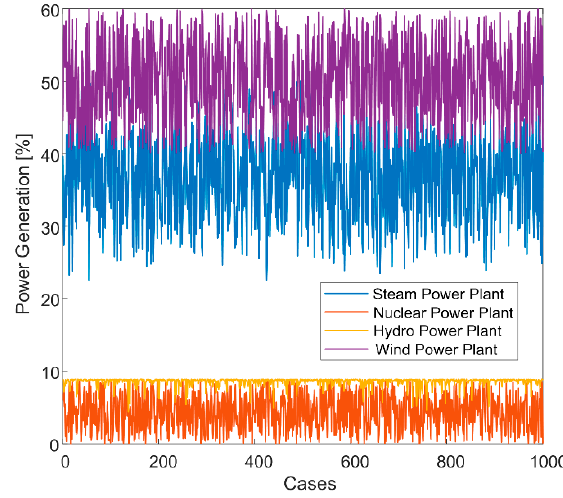
Figure 8. Various power system operation cases, including different generation shares of conventional and wind power plants, to analyze the optimized parameters.